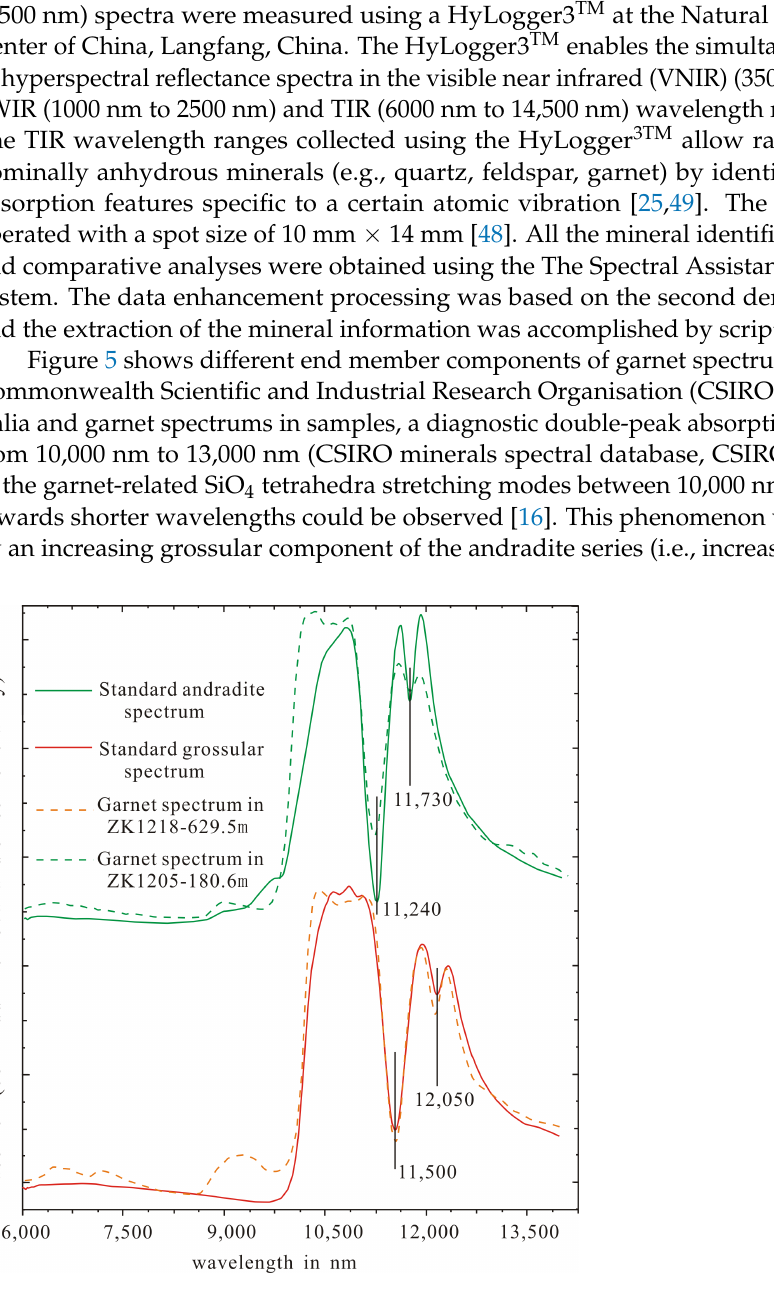
Figure 5. Characteristic spectra of garnet minerals (standard spectra from CSIRO TIR spectral database).